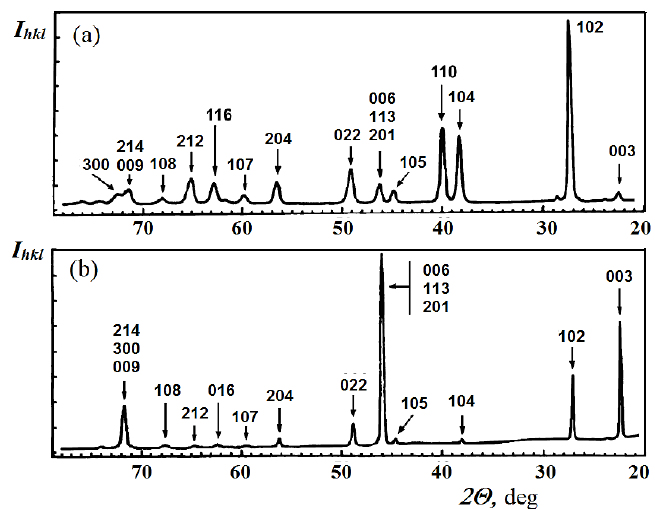
Figure 4. Diffraction patterns for a crystal Bi 0.91 Sb 0.09 after plastic deformation. ( a ) Textureless reference sample, ( b ) sample after extrusion at K e = 5 and annealing at 453 K for 8 h. Miller indices are given in the hexagonal setting for the [111] planes; 2 θ is the doubled Bragg angle. Table 1. Influence of the extrusion ratio and annealing temperature for 8 h on the content of the crystallographic texture (W <111> × 100%) in the direction of the extrusion axis. K e No